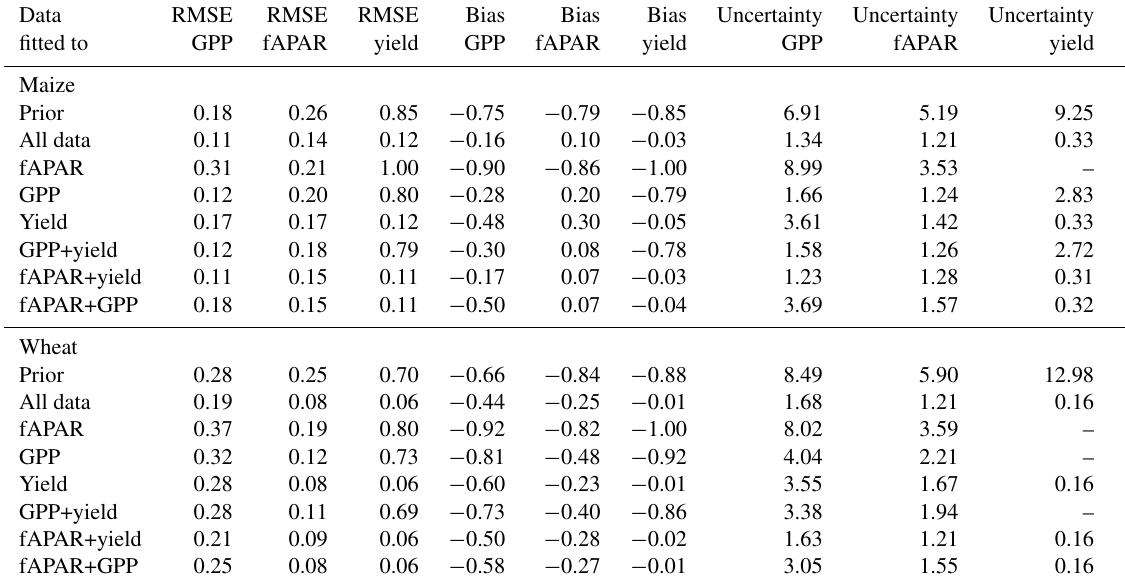
Table 4. RMSE, bias and uncertainty values in the data knock-out experiments for wheat and